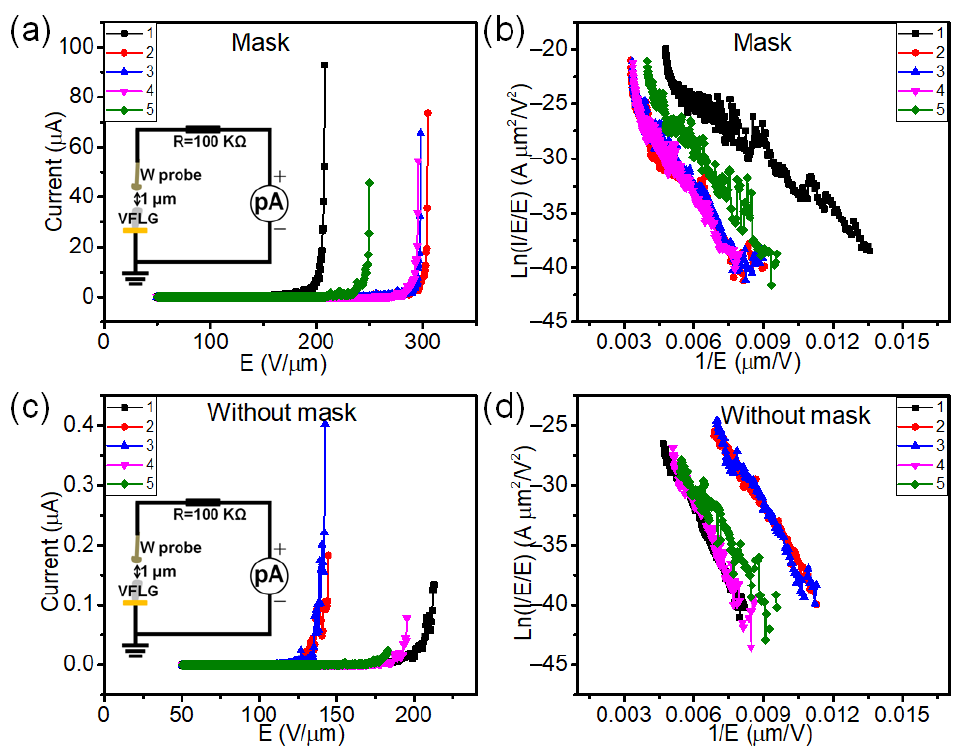
Figure 5. Field emission characteristics of single VFLG sheet. ( a ) Field emission I–V curves of randomly selected five single HCVFLG sheets and corresponding F–N curves ( b ). ( c ) Field emission I–V curves of randomly selected five single VFLG sheets which grow without using Cu mask and corresponding F–N curves ( d ). Inset images of ( a ) and ( c ) are circuits of test. All the tests work in DC voltage mode.